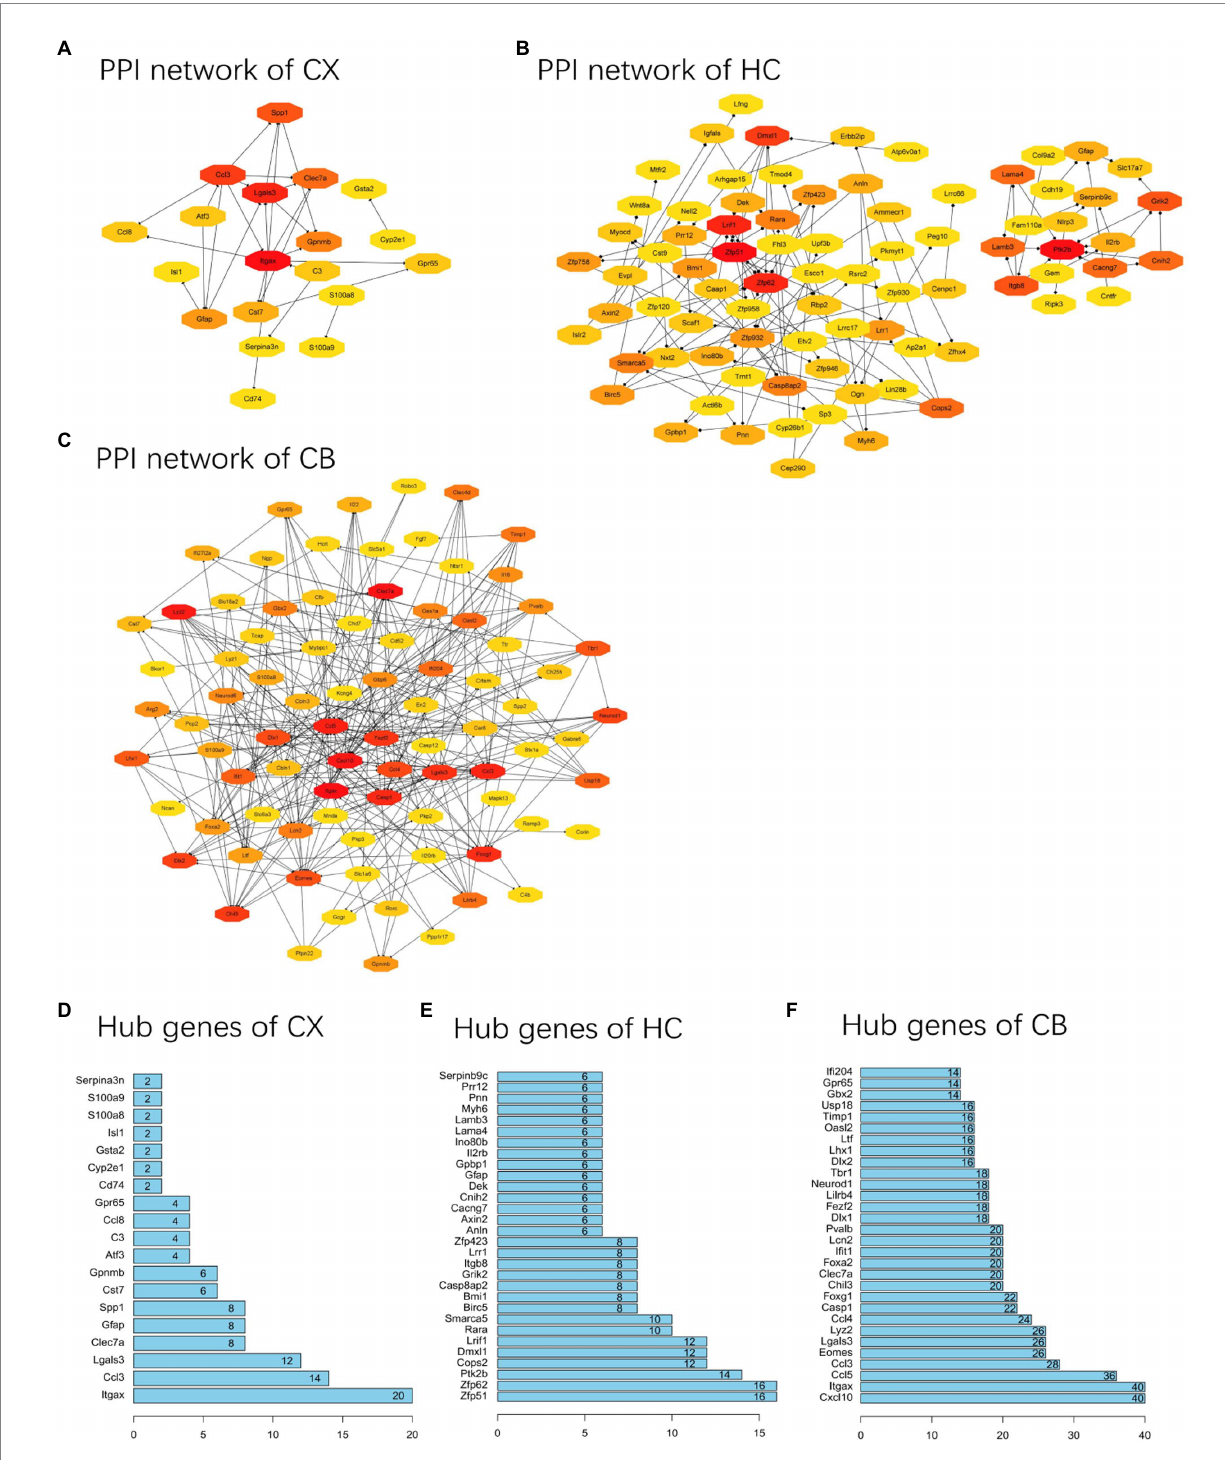
FIGURE 7 PPI networks and hub genes of DEGs. (A-C) The results of network analysis based on Cytoscape. The depth of color represents the degree of gene in network analysis. (D-F) The results of network analysis based on R software. The x-axis represents the number of gene connections in network. CX, cerebral cortex; HC, hippocampus; CB,